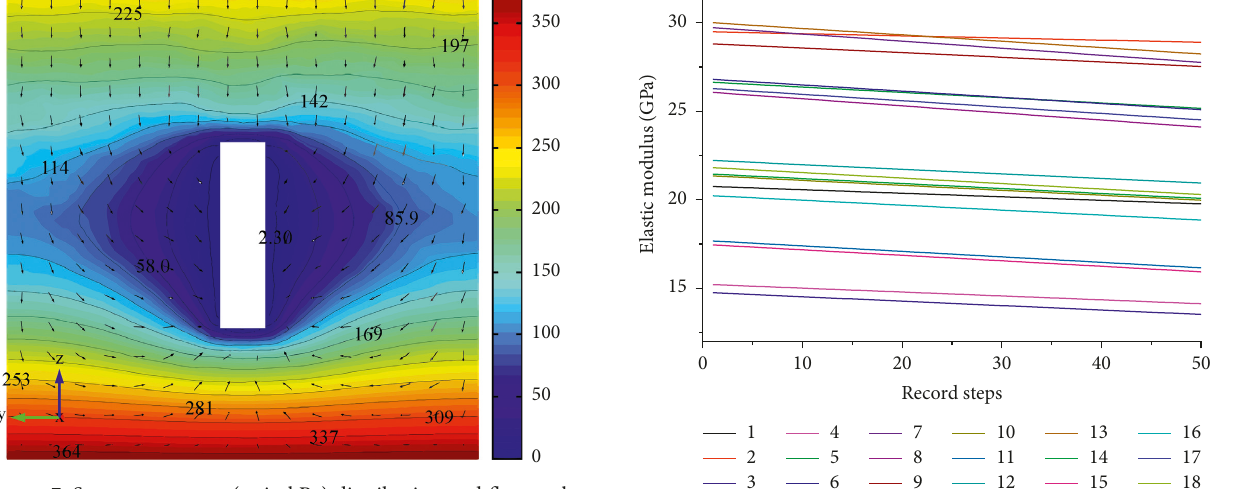
Figure 7: Seepage pressure (unit: kPa) distribution and flow path.